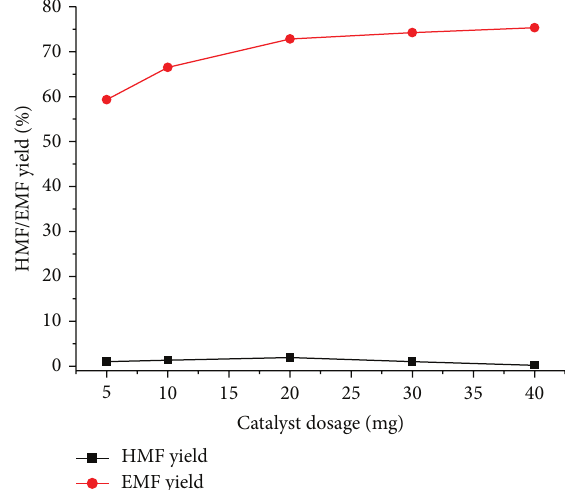
Figure 6: The effect of catalyst loading on one-pot dehydrative etherification of fructose in ethanol to EMF with poly(VMPS)-PW at 110 ∘ C for